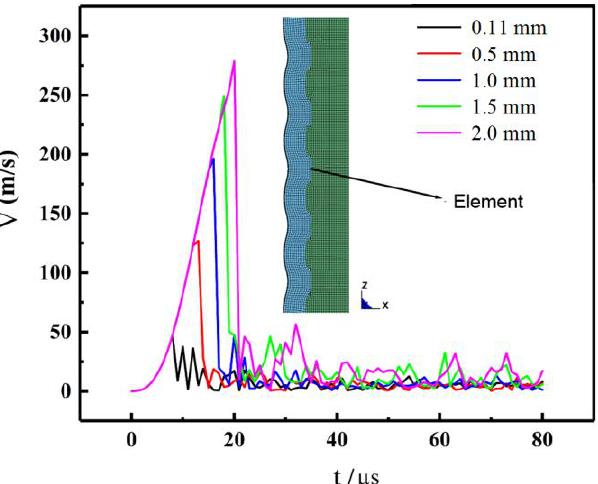
Figure 17. Variation curve of element velocity with time under different initial gap conditions. The groove embedment rate was measured under the conditions of different pipe-tube sleeve initial gaps. As shown in Figure 18, the embedment rate was 88.7% under the condition of a 1 mm initial gap, which reached the requirement of 85%. When the gap reached 1.5 mm and 2 mm, the groove embedment rate was close to 100%, but the groove edge “ slumped ” . Therefore, in the variable gap electromagnetic bulging process scheme,